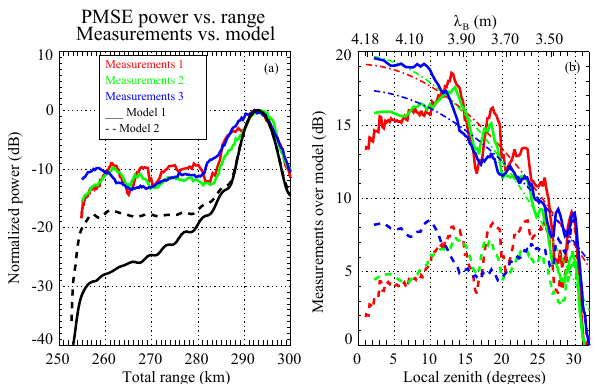
Figure 8. (a) Normalized power cuts as a function of total range for three different time periods in Fig. 5a in red, green, and blue. The expected relative power for an isotropic scattering is indicated in black. (b) Power ratio between measurements and isotropic power. Fitted curves centered at 0 ◦ are indicated in dashed-dotted lines.